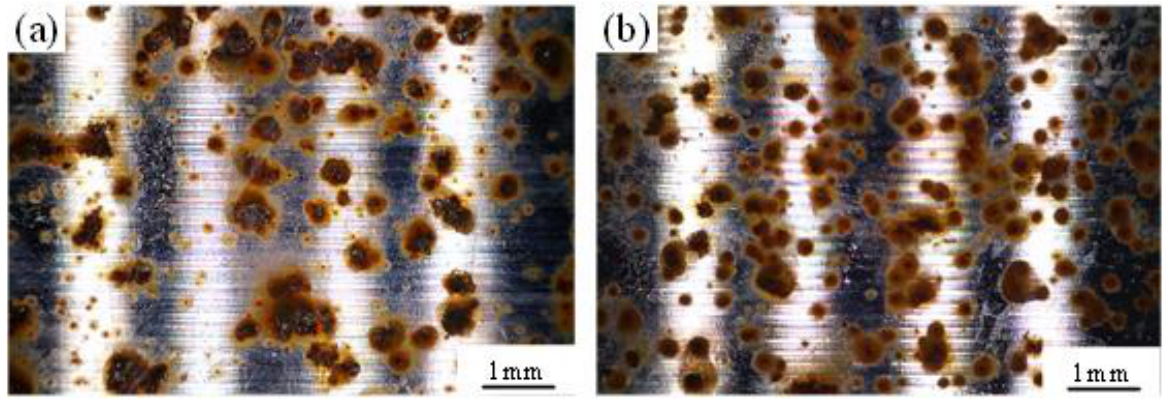
Figure 18. Morphologies of samples obtained in ( a ) Experiment #5 and ( b ) Experiment #6 under salt spray corrosion for 30 min.